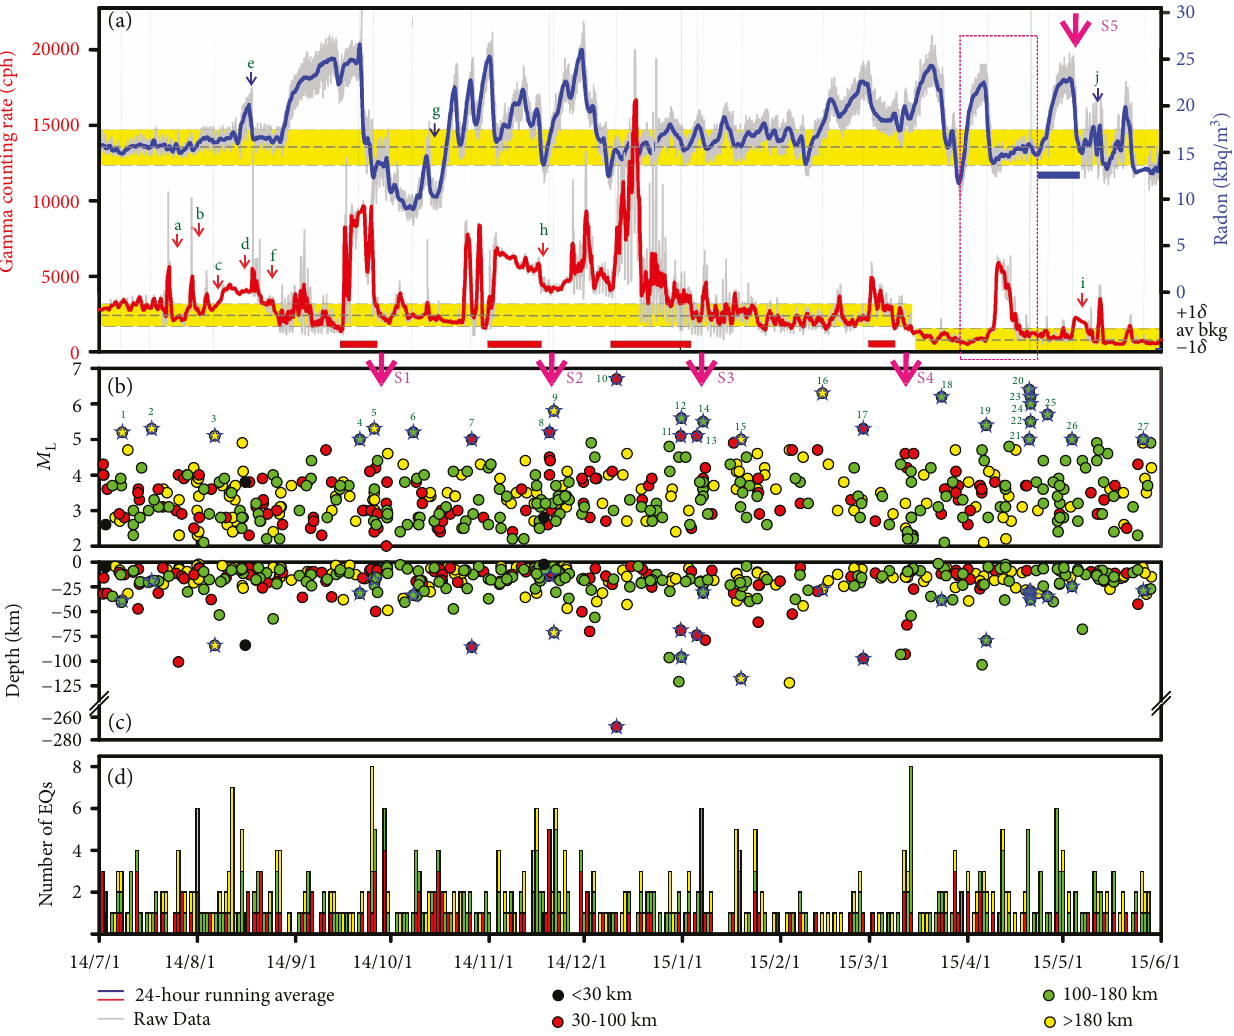
Figure 4: The temporal variations of (a) radon and gamma rays from July 1, 2014, to June 1, 2015. Blue and red lines indicate the 24-hour running averages of radon and gamma ray data, respectively; grey lines represent the raw data. Horizontal dashed lines indicate the annual averages of the observed results, and the anomalous threshold value ( ± 1 σ ) is included with the yellow bar. The magnitude and depth of earthquakes are plotted in (b) and (c), respectively. The circle symbols in di ff erent colors indicate that the epicenter distance of the earthquake to YMSG station was < 30 km (black), 30 to 100km (red), 100 to 180km (green), and > 180km (yellow). Red and blue arrows indicate the speci fi c seismic events. The accumulated number of earthquakes at di ff erent distances is also shown as a histogram (d). One speci fi c period of time marked by the dashed rectangle is enlarged in Figure